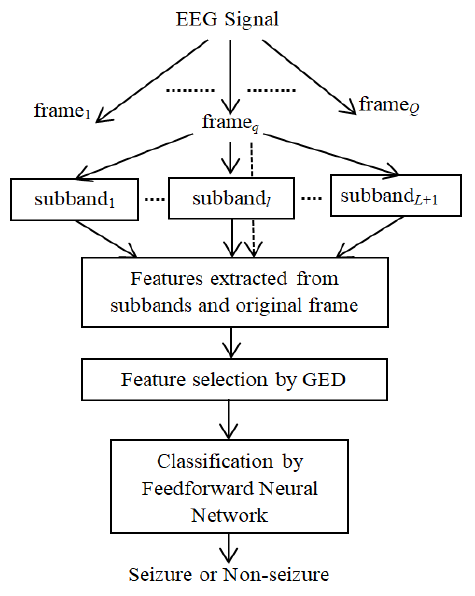
Figure 2. Block diagram of the proposed method (GED: graph eigen decomposition).